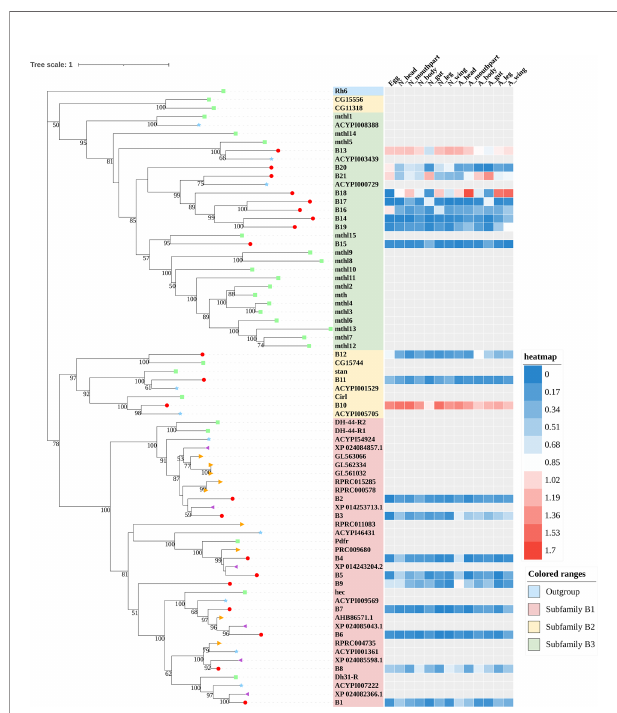
FIGURE 3 | Phylogenetic tree reconstruction of Family-B GPCRs from D. melanogaster (green square), A. pisum (blue star), R. prolixus (orange right triangle), C. lectularius (purple left triangle), and A. lucorum (red circle) inferred from maximum likelihood (ML) analysis. Numbers at nodes on the tree were the bootstrap values (below 50 are not shown). The tree was rooted by the D. melanogaster opsin GPCR Rh6. Expression pro fi les of A. lucorum GPCR genes from different tissues are shown in the corresponding branch side. The transcription level of each gene is represented by a square with a color that codes for the values of Lg (TPM+1). N, nymph; A,